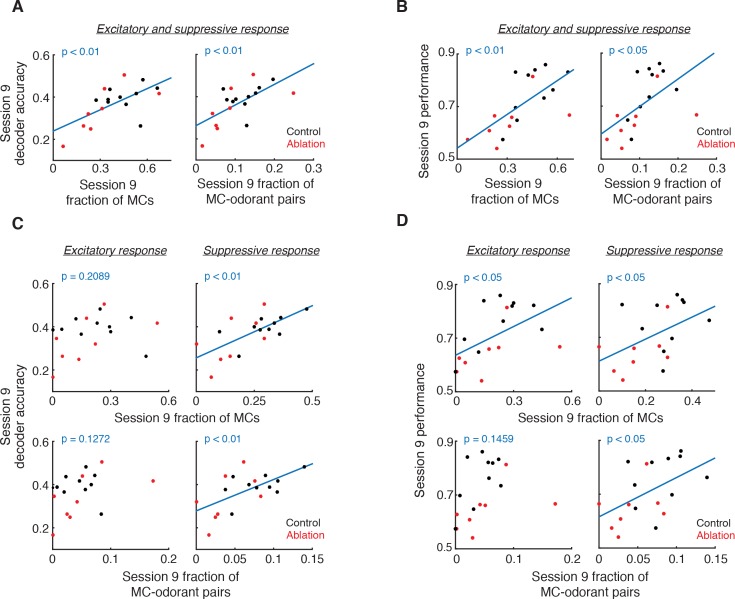
Relationship of responsive MC fractions with MC ensemble discriminability and behavioral performance.(A) Session 9 decoder accuracy correlates with fraction of responsive MCs (left, p<0.01, Pearson correlation) and MC-odorant pairs (right, p<0.01, Pearson correlation). (B) Session 9 behavioral performance correlates with fraction of responsive MCs (left, p<0.01, Pearson correlation) and MC-odorant pairs (right, p<0.05, Pearson correlation). (C) Session 9 decoder accuracy correlates with suppressive but not excitatory MC responses. Top left: excitatory MCs, p=0.2089; bottom left: excitatory MC-odorant pairs, p=0.1272; top right: suppressive MCs, p<0.01; bottom right: suppressive MC-odorant pairs, p<0.01, Pearson correlation. (D) Session 9 behavioral performance correlates with MC suppressive responses. Top left: excitatory MCs, p<0.05; bottom left: excitatory MC-odorant pairs, p=0.1459; top right: suppressive MCs, p<0.05; bottom right: suppressive MC-odorant pairs, p<0.05, Pearson correlation.